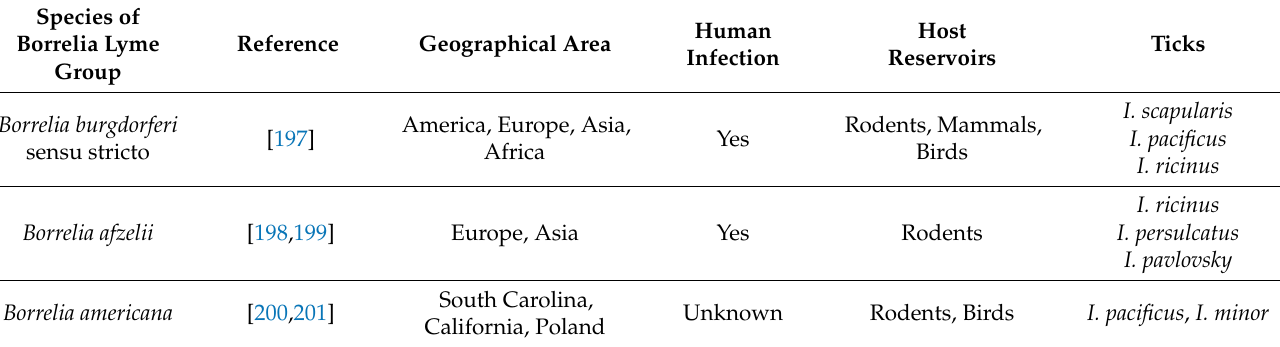
Table 6. Borrelia Lyme group A and